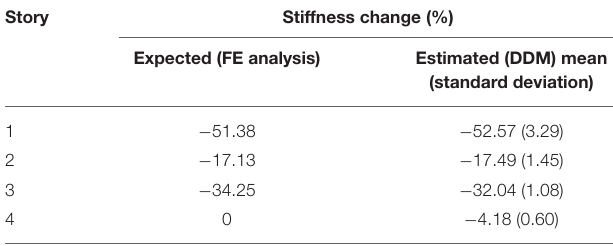
TABLE 6 | Story stiffness change (DC